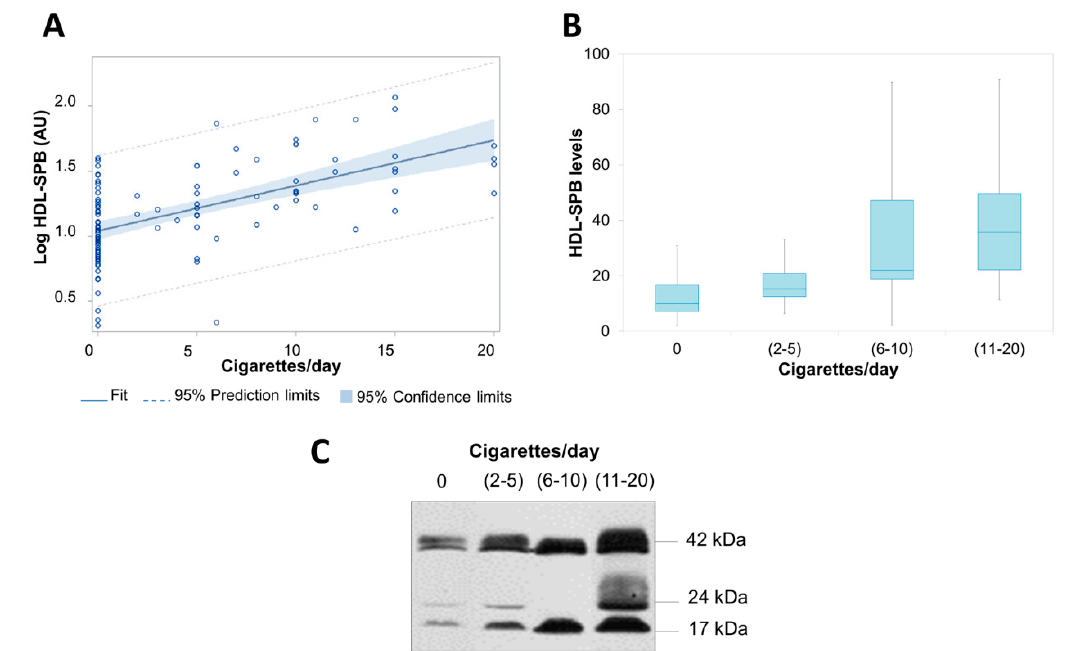
Figure 1. Levels of high-density lipoprotein-associated immature surfactant protein B (HDL-SPB) and current smoking. ( A ) Association of log-transformed HDL-SPB and number of daily smoked cigarettes (cigarettes/day). p < 0.0001 by linear regression. ( B ) Distribution of HDL-SPB in relation to tertiles of daily smoked cigarettes. ( C ) Representative image of the HDL-SPB analysis obtained by immunoblotting technique in a no smoker and in smokers from each tertile of daily smoked cigarettes. p -value for trend was assessed by Spearman correlation; p < 0.0001.